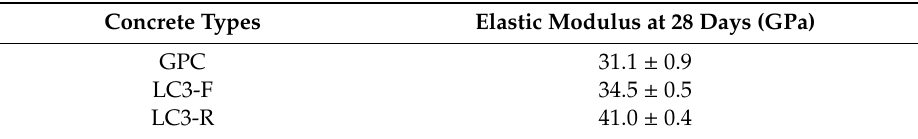
Table 4. Elastic modulus of concretes.